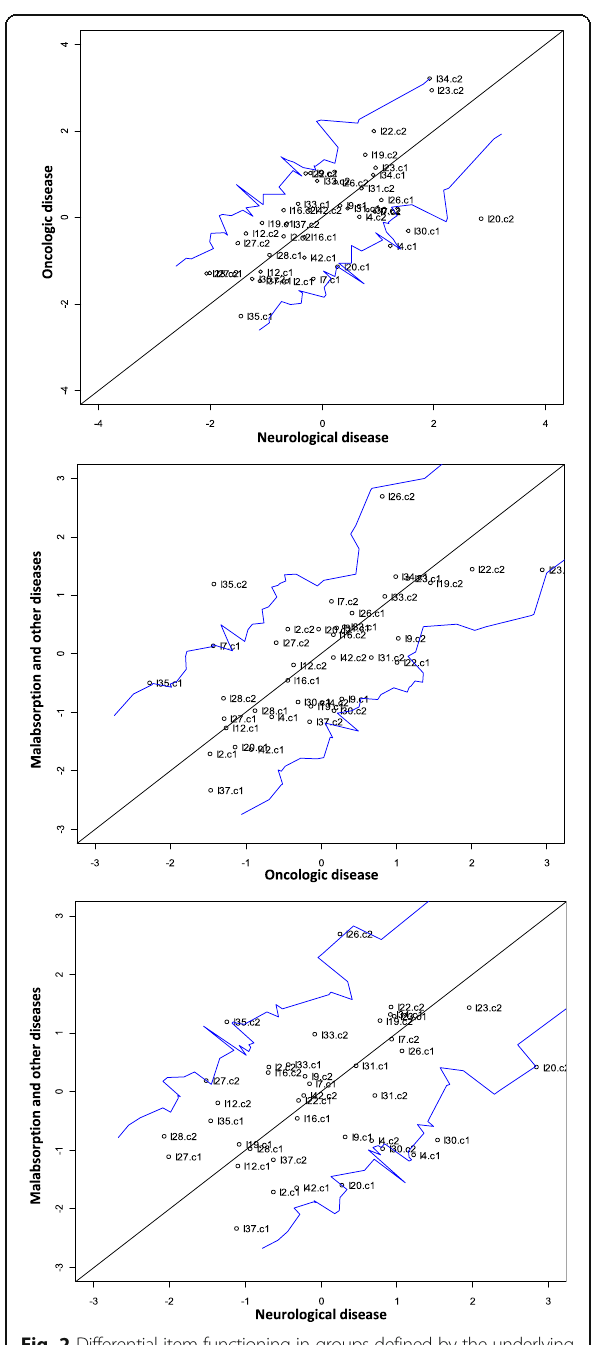
Fig. 2 Differential item functioning in groups defined by the underlying disease (oncologic vs. neurological, malabsorption vs. oncologic and malabsorption vs. neurological disease)